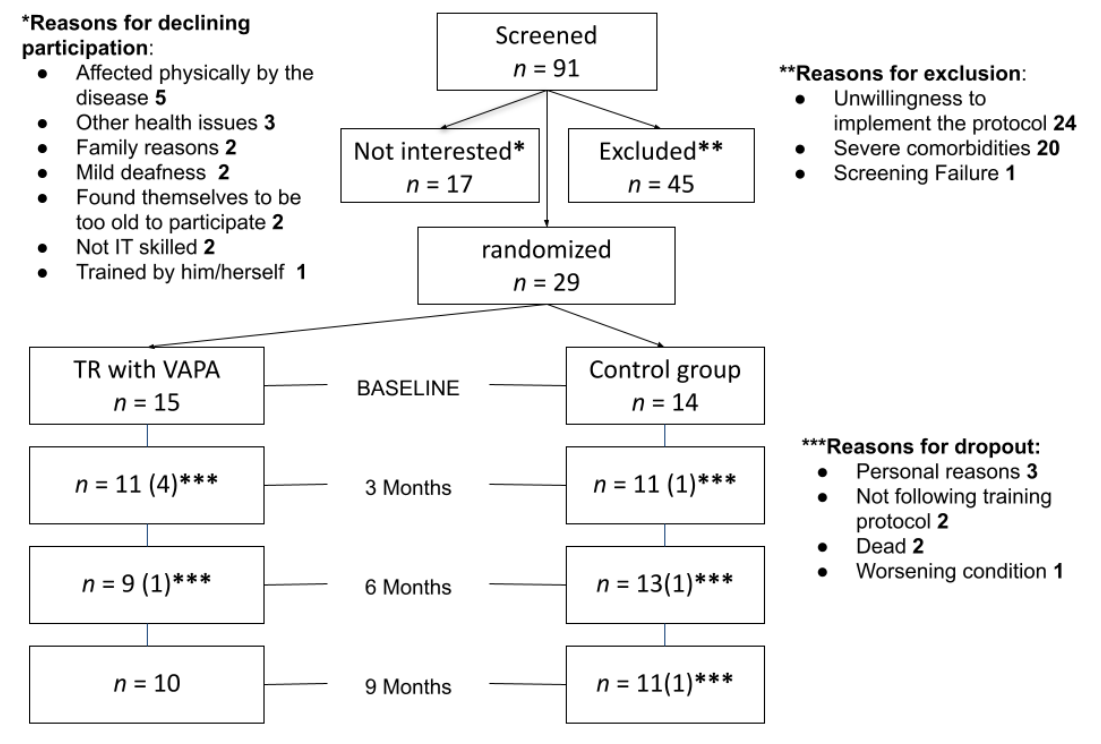
Figure 2. Enrollment and randomization in the overall population. Table 2. Baseline demographics of the 29 patients included in the